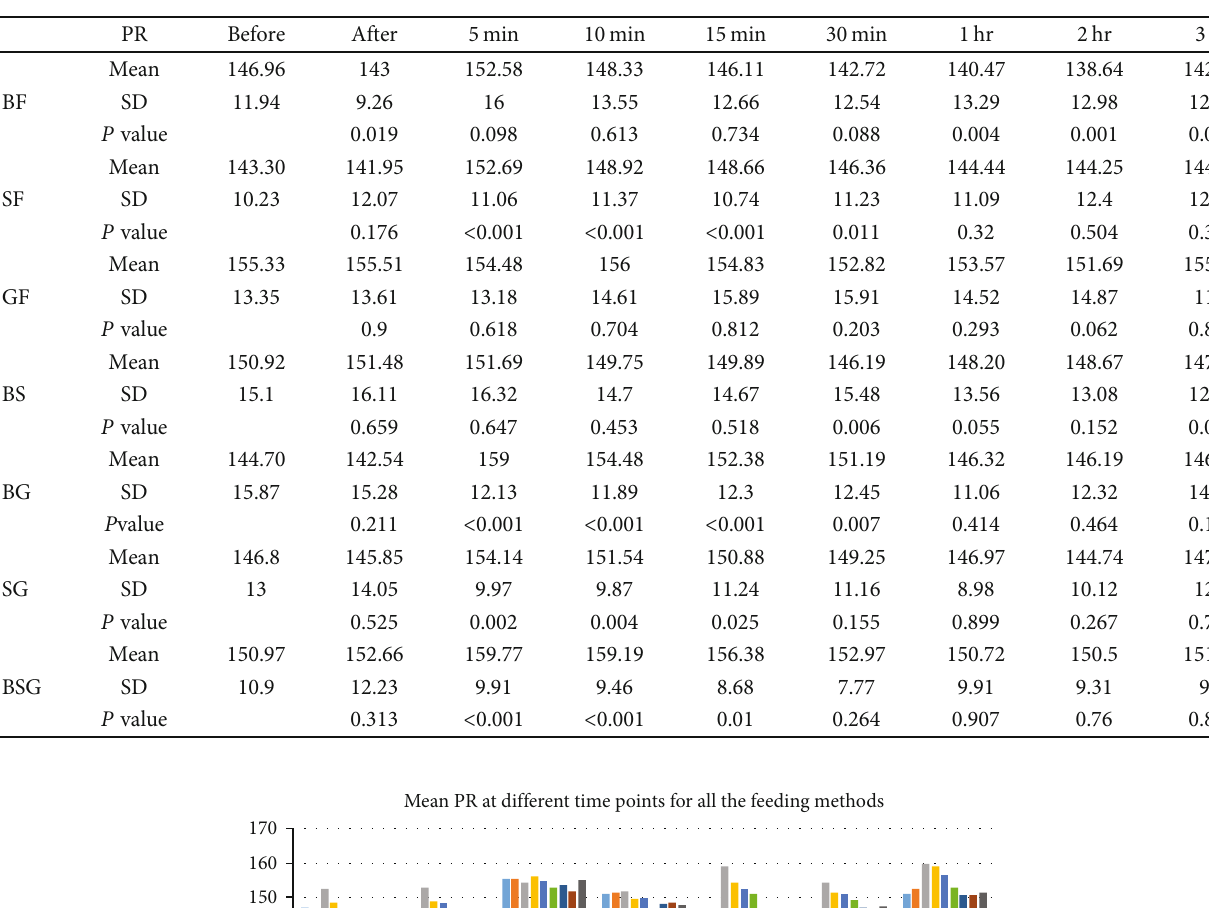
Table 3: PR at di ff erent time points for all the feeding methods.